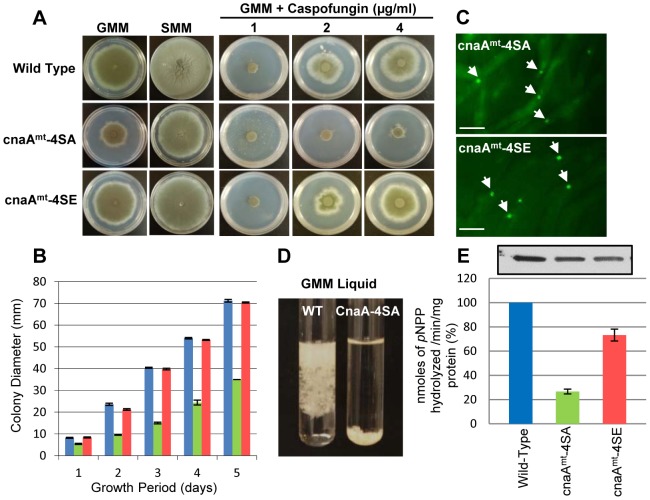
Phosphorylation of CnaA is required for proper hyphal growth.(A) Radial growth after 5 days at 37°C on GMM agar and GMM supplemented with 1.2 M sorbitol (SMM) to assess growth remediation. Wild-type, cnaAmt-4SA, and cnaAmt-4SE strains (1×104 conidia each) were cultured on GMM in varying concentrations of caspofungin for 5 days. The cnaAmt-4SA strain, defective in phosphorylation, exhibits a growth defect and lacks caspofungin-mediated paradoxical growth due to lack of calcineurin activity. (B) Radial growth is depicted as mean colony diameter in triplicate during 1–5 days growth period. (C) Localization of the CnaA mutated constructs by fluorescence microscopy after 24 h growth. (D) Growth reduction of the cnaAmt-4SA in comparison to the wild-type strain after inoculating 1×106 conidia into GMM liquid and growth for 48 h at 37°C. (E) Calcineurin activity after 24 h growth using p-nitrophenyl phosphate as a substrate. Data from two separate experiments, each with 6 technical replicates are presented as mean ± SD of nanomoles of pNPP released/min/mg protein.